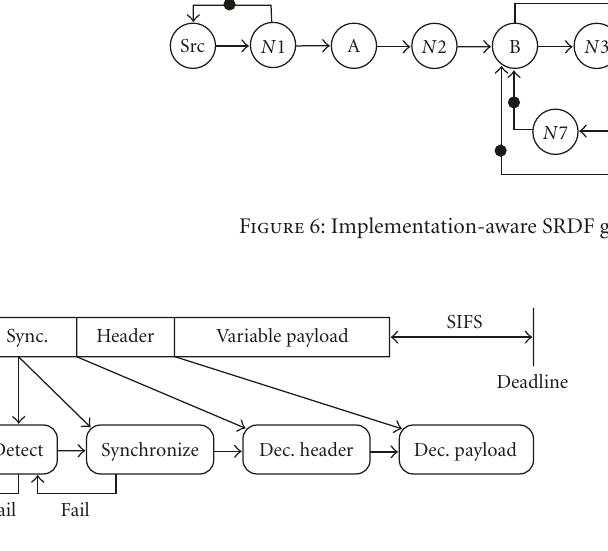
Figure 7: Real-time requirements and state diagram for 902.1b (WLAN) reception